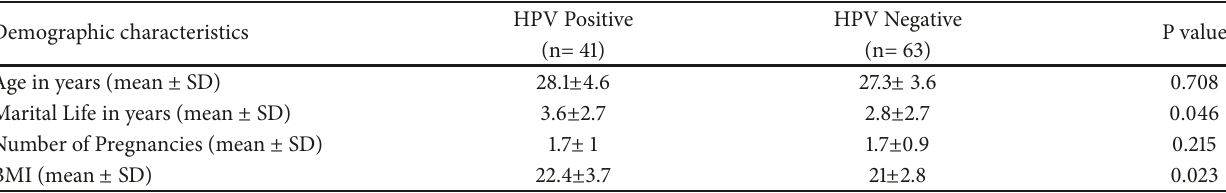
Table 1: Comparison of basic demography between the HPV positive and negative groups.